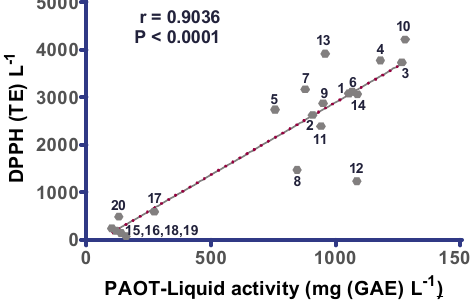
Figure 4. Correlation between PAOT-Liquid ® activity and DPPH assay in red ( n = 14), rosé ( n = 3) and white wines ( n = 3) bought in a Belgian commercial market.